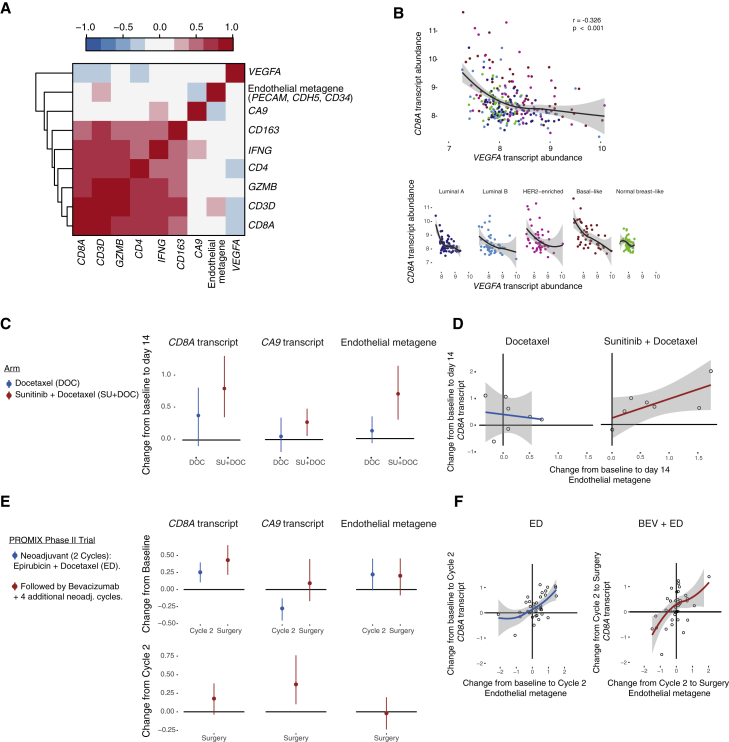
CD8A Transcript Abundance in Human Breast Cancer Positively Correlates with an Endothelial Cell Metagene(A) Correlation analyses between VEGFA, CA9, and an endothelial metagene (PECAM, CDH5, CD34); and a set of immunogenes in the Uppsala cohort. Colorgram of Spearman's rank correlation matrix where the gene transcript levels are arranged according to hierarchical clustering. Red indicates positive correlation and blue, negative correlation. CD8A versus endothelial metagene Spearman's correlation coefficient rho = 0.191, p = 0.0023.(B) Correlation between CD8A and VEGFA transcript abundance in the Uppsala cohort, and according to breast cancer subtype (mean values with confidence interval).(C) Docetaxel- and sunitinib + docetaxel-induced changes from baseline in the expression of the indicated transcripts and metagene 14 days after treatment in breast cancer patients (vertical lines represent 95% confidence intervals).(D) Correlations between the changes in CD8A transcript and endothelial metagene abundance from baseline to 14 days after the indicated treatments (mean values with confidence interval).(E) Her2-negative breast cancer patients received two cycles of epirubicin and docetaxel (ED), followed by ED plus bevacizumab for four additional cycles (BEV + ED). Change in the expression of the indicated transcripts and metagene from baseline to the second cycle and to surgery (top), and from the second cycle to surgery (bottom). Multi-center, single arm, phase 2 PROMIX clinical trial; vertical lines represent 95% confidence intervals.(F) Correlations between the changes in CD8A transcript and endothelial metagene abundance from baseline to second cycle (epirubicin + docetaxel) and second cycle to surgery (bevacizumab + epirubicin + docetaxel) in the PROMIX trial (mean values with confidence interval). Transcript abundance values represent log2-transformed probe intensity values.See also Figure S4.